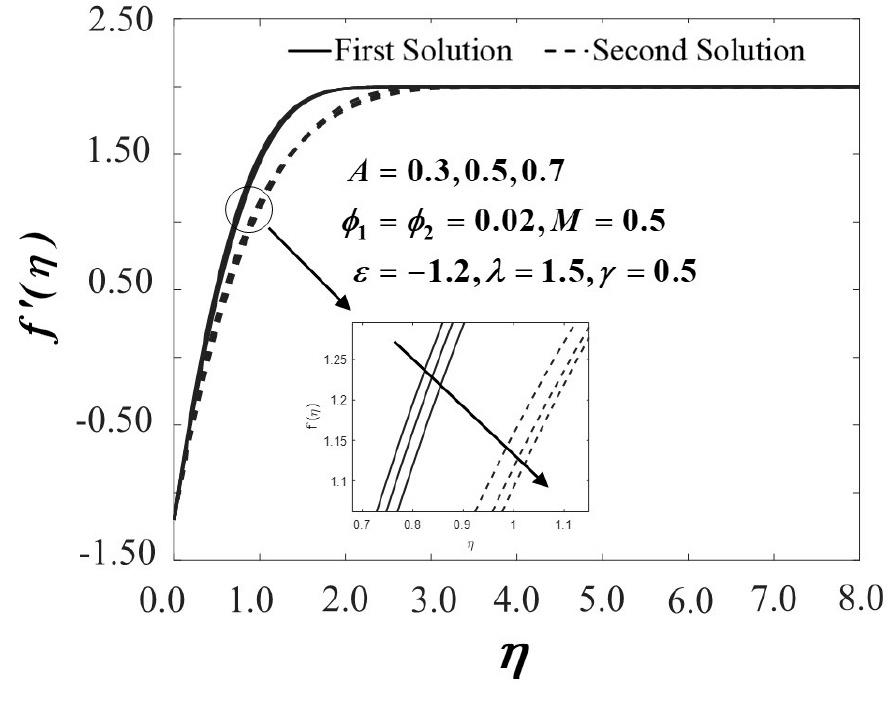
Figure 19. Velocity profiles of f (cid:48) ( η ) for di ff erent values of A .